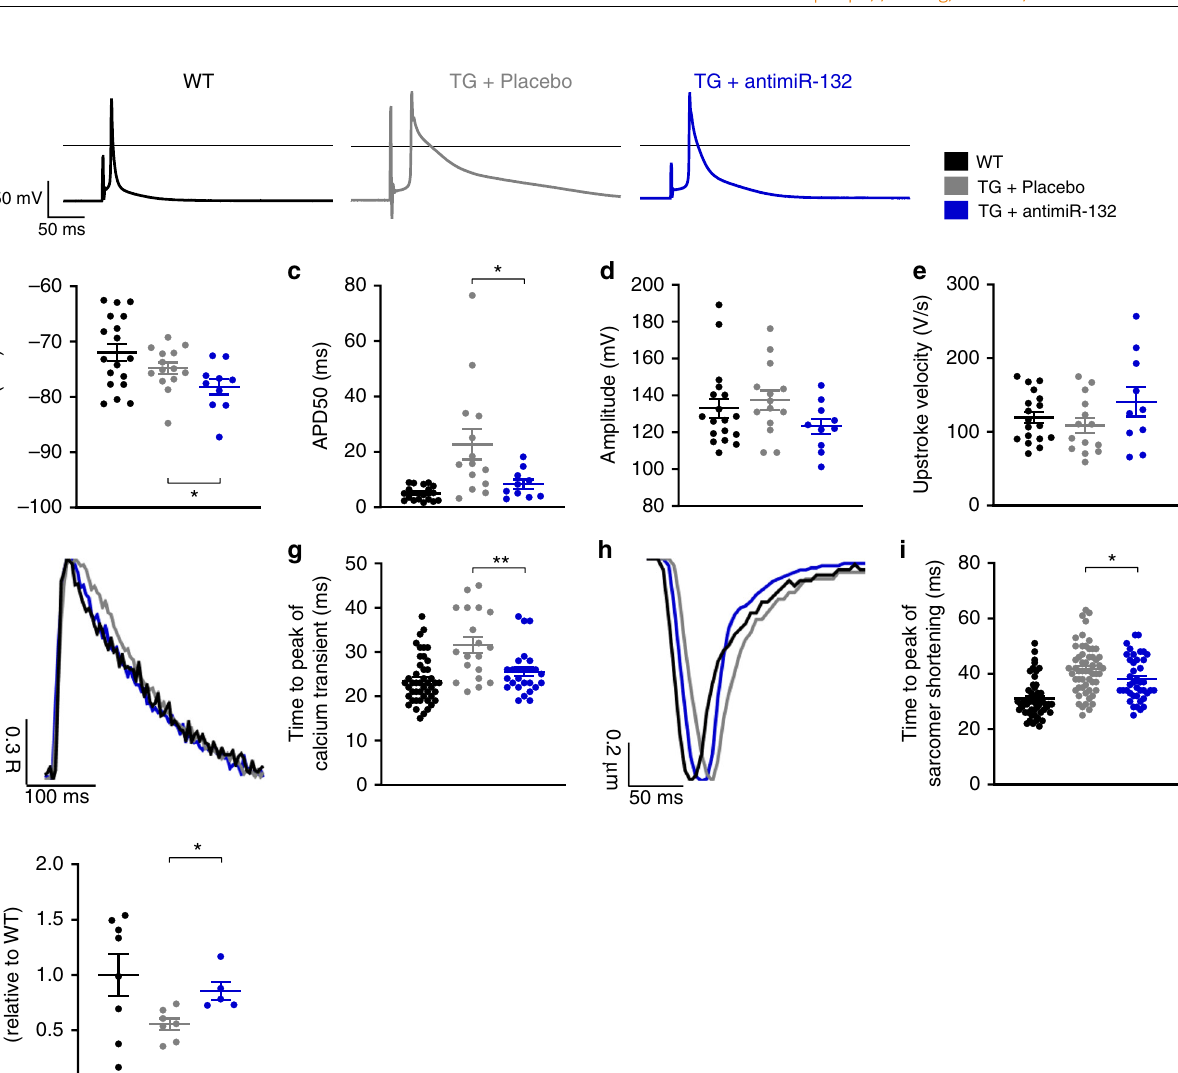
Fig. 2 Functional properties of single cardiomyocytes. a Representative action potential traces of adult ventricular cardiomyocytes derived from wildtype (WT), miR-212/132 transgenic (TG) mice treated with placebo (0.9% NaCl solution) or antimiR-132. b Resting membrane potential (RMP). c Action potential duration at 50% level of repolarization (APD50). d Action potential amplitude. e Upstroke velocity. (WT: n = 18 cells, TG + NaCl: n = 14 cells, TG + antimiR-132: n = 10 cells) f Representative normalized calcium transients. g , Time-to-peak (ttp) of calcium transients at 3 Hz stimulation frequency. (WT: n = 46 cells, TG + NaCl: n = 19 cells/, TG + antimiR-132: n = 26 cells) h Representative normalized sarcomere shortening. i Time-to-peak (ttp) of sarcomeric contraction at 3 Hz stimulation frequency. (WT: n = 52 cells, TG + NaCl: n = 57 cells, TG + antimiR-132: n = 41 cells). j MiR-132 target gene expression in heart tissue (Sarcoplasmic/Endoplasmic Reticulum Ca 2 + ATPase 2, Serca2a2 ). (WT: n = 8, TG + NaCl: n = 7, TG + antimiR-132: n = 5.) Data are mean ± s.e.m; * P < 0.05; ** P < 0.01; unpaired two-sided Mann – Whitney U